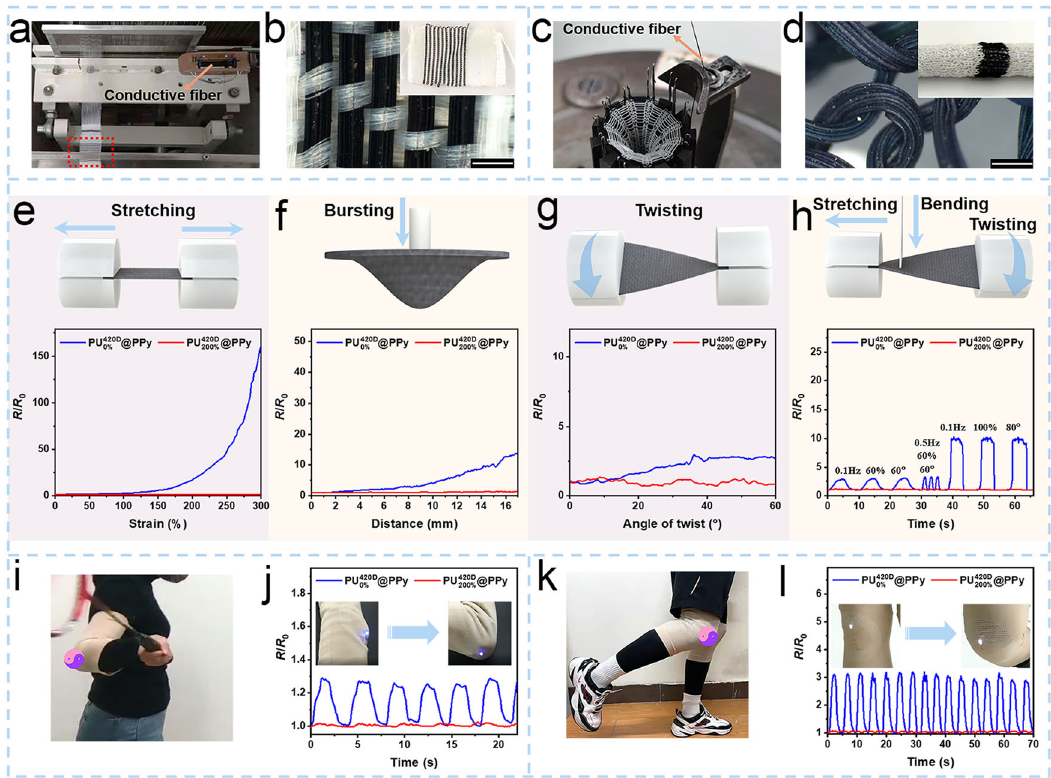
Fig. 6 Integration of PU 420D @PPy multi fi lament using textile technology and its potential applications. Optical images of a rapier loom 200% machine, b fabric with conductive multi fi lament obtained by weaving, c circular knitting machine and d fabric with conductive multi fi lament obtained by knitting. Scale bar is 0.5 mm. Resistance changes of the fabric during e stretching, f bursting, and g twisting. h Dynamic resistance changes of the fabric under multiple deformations. Application of the fabric as stretchy electronics during i , j arm bending and k , l